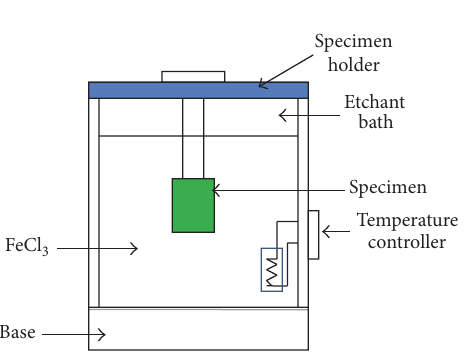
Figure 5: Experimental set-up.